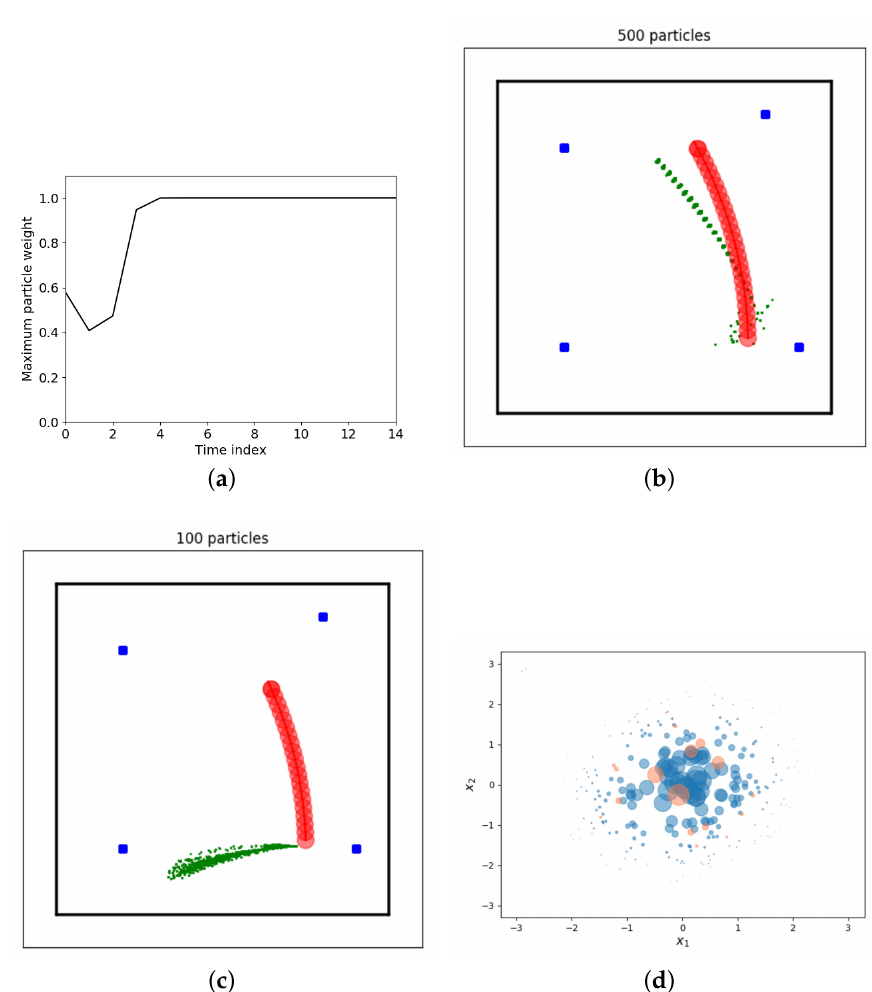
Figure 5. Visualizations of four out of the five challenges identified for particle filters. ( a ) Challenge I: degeneracy. ( b ) Challenge II: sample impoverishment. Red: robot trajectory, blue: landmarks, green: particles at different time steps. ( c ) Challenge III: particle filter divergence. Red: robot trajectory, blue: landmarks, green: particles at different time steps. ( d ) Challenge IV: selecting the importance